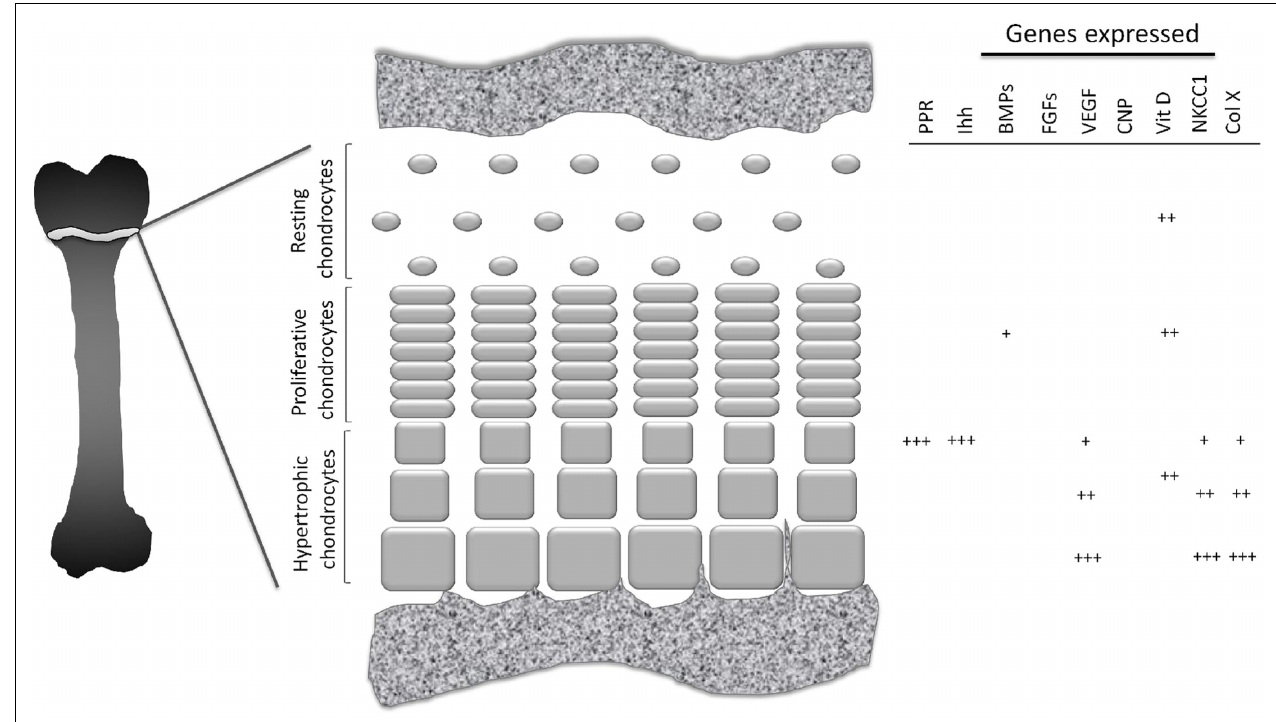
FIGURE 1 | Schematic picture of growth plate cartilage. At different stages in their development growth plate chondrocytes exhibit different pattern of gene